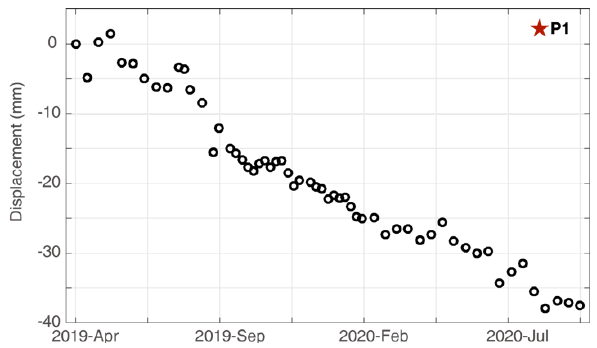
Figure 5 . Time-series displacement of P1 on Fuling Road. Figure 3 . Subsidence velocity of Fuling Sub District during 2019 – 2020. The rectangles represent the corresponding locations in Figure 4 and 5. The white dash line represents Fuling Road.